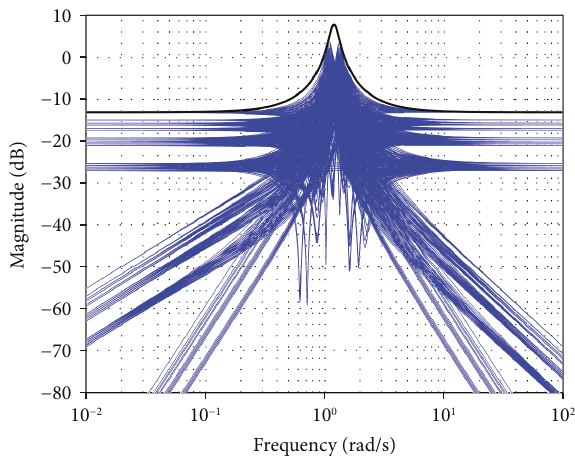
Figure 17: Envelope of Nyquist diagrams for FO plant family (35) and controller (31).